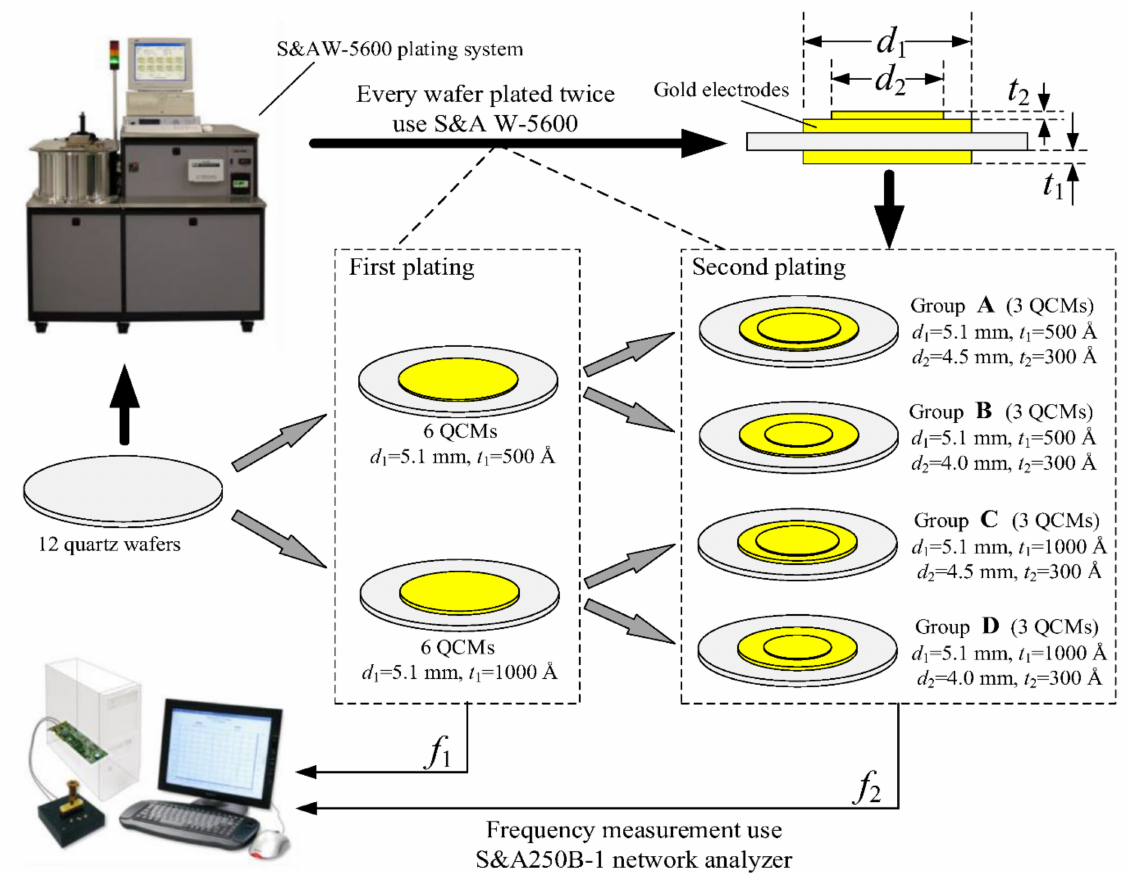
Figure 1. Schematic diagram of the experimental setup for testing the mass sensitivity of a QCM using vacuum coating method